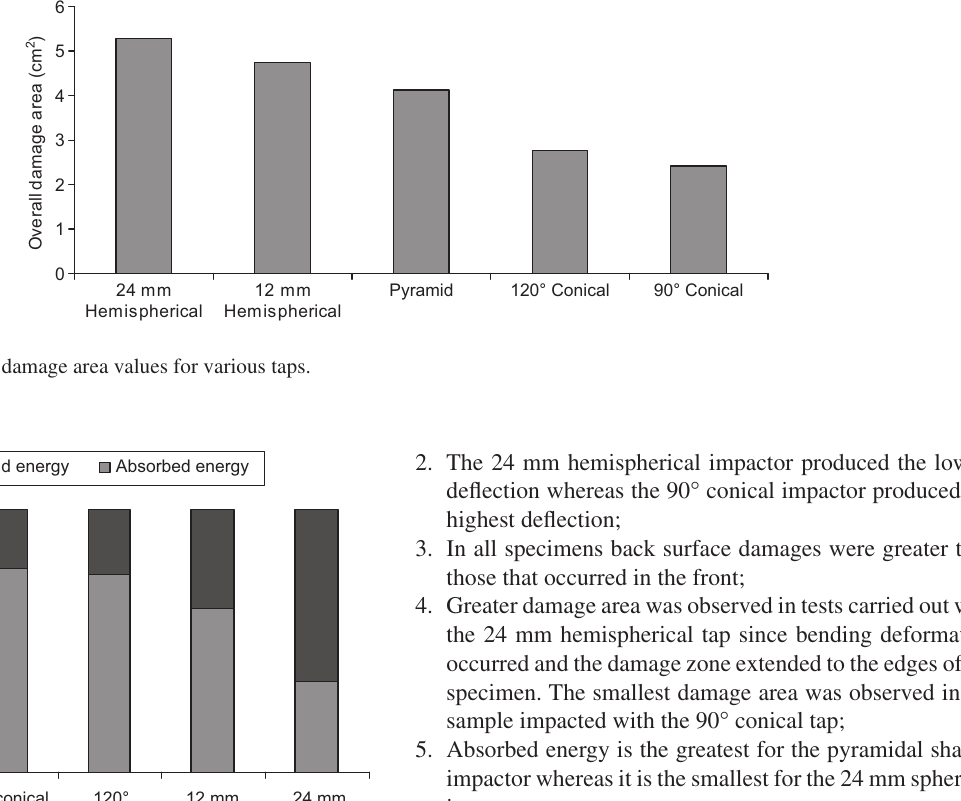
Figure 12 Energy distributions for various taps.